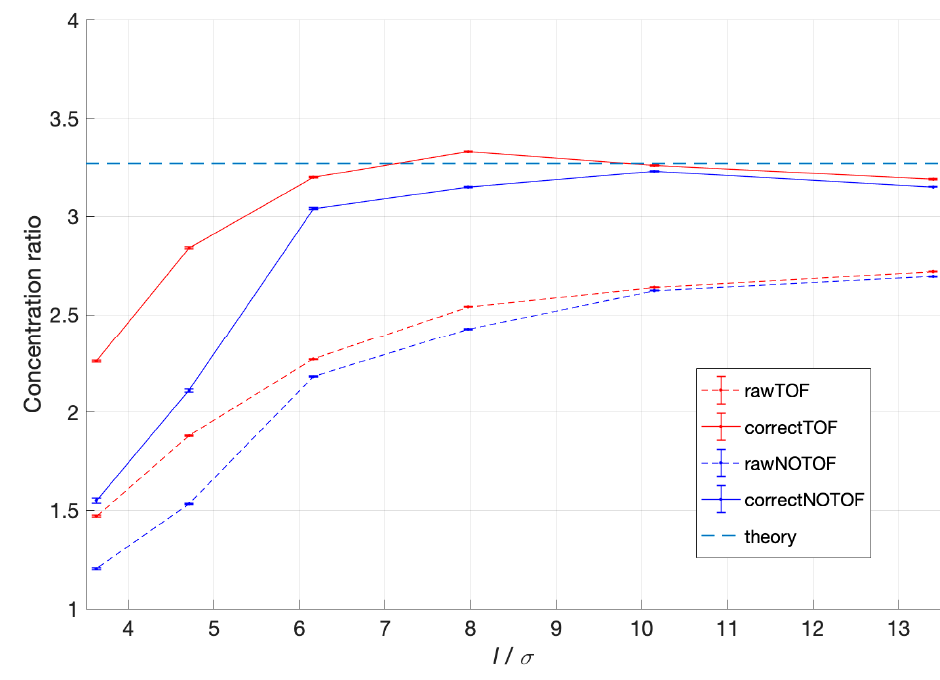
Figure 4. Comparison of the concentration ratio for the same acquisition time (4 min) between the reconstruction with TOF correction, reported in red, and the one without TOF, reported in blue, before (dotted line) and after (continuous line) the application of PVE recovery method.